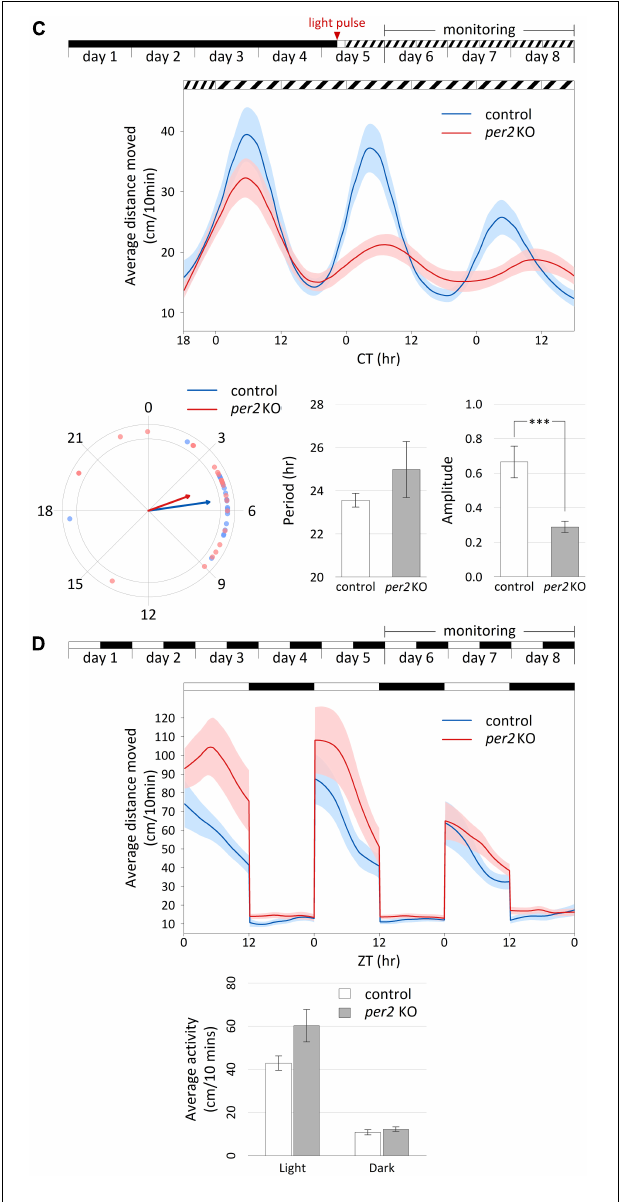
FIGURE 2 | Per2 KO affects the phase of circadian rhythms of locomotor activity and their entrainment by light. Analysis of locomotor activity of 6–8 dpf per2 KO and control larvae under various lighting conditions. (A–D) Top, experimental design of the photic treatment prior to and throughout activity monitoring. White boxes represent light, black boxes represent dark, and diagonally lined boxes represent dim light. Middle, the average distance moved (cm/10 min) is plotted on the y -axis and circadian time (CT) for panels (A–C) or zeitgeber time (ZT) for panel (D) is plotted on the x -axis; error bars indicate SE. (A–C) Bottom from left to right, comparison of average phase, period ( ± SE) and amplitude ( ± SE) between genotypes. In the circular plot of circadian phase, arrow direction represents the average phase for each genotype and the length represents the variance (longer arrow stands for low variance and vice versa). (D) Bottom, comparison of average activity ( ± SE) between genotypes throughout the light and dark segments. (A) Circadian rhythms of locomotor activity under DimDim, after entrainment by 3 LD cycles and 2 light-dim light (LDim) cycles; per2 KO larvae ( n = 21) display